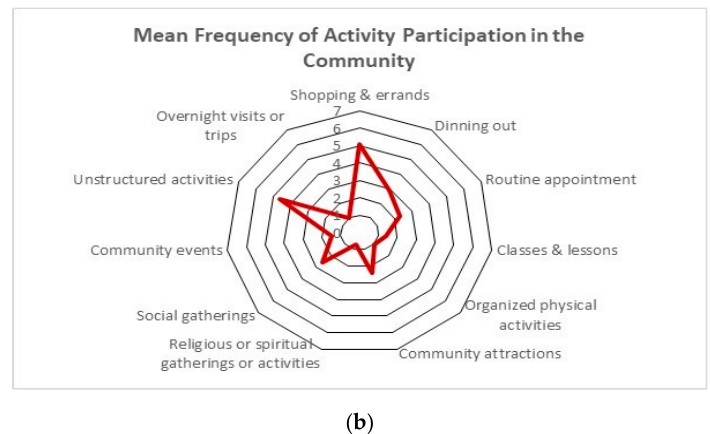
Figure 1. ( a ) Mean frequency of activity participation at home, ( b ) mean frequency of activity participation in the community.